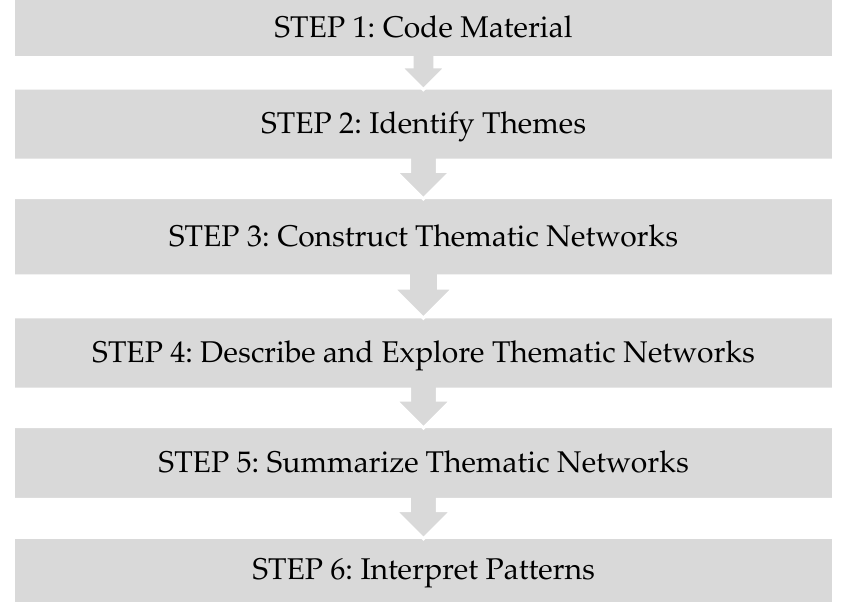
Figure 1. The six steps in the Thematic-Network Analysis.